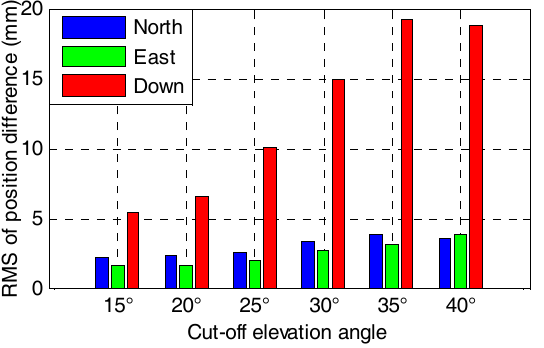
Figure 17. RMS of positioning difference of GPS/BDS/INS with elevation cut-off angles of 15, 20, 25,